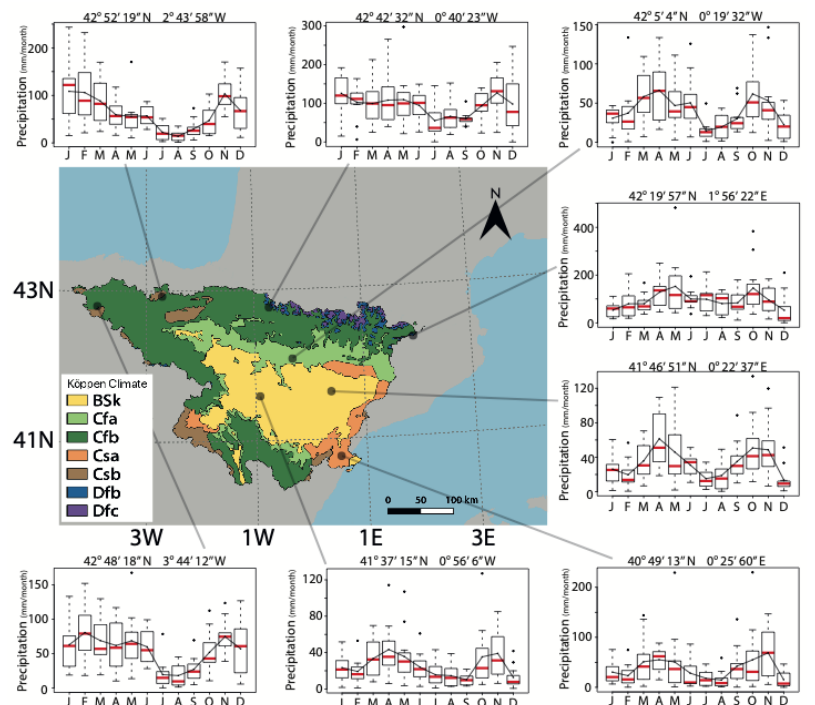
Figure 2. Extended-Köppen climate classification map of the study area. Boxplots of the monthly precipitation for eight selected locations and the 2008–2018 period. Units are mm/month.